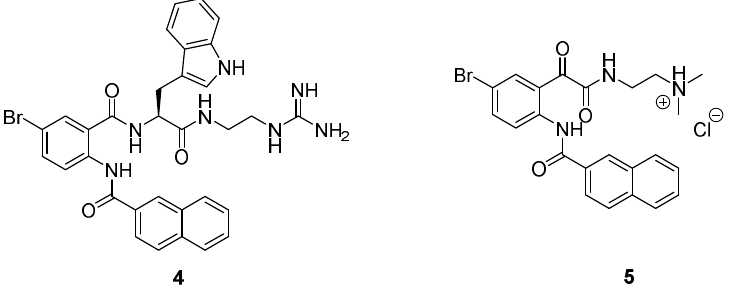
Figure 3. Synthetic antimicrobial peptide mimics that were reported by our group.